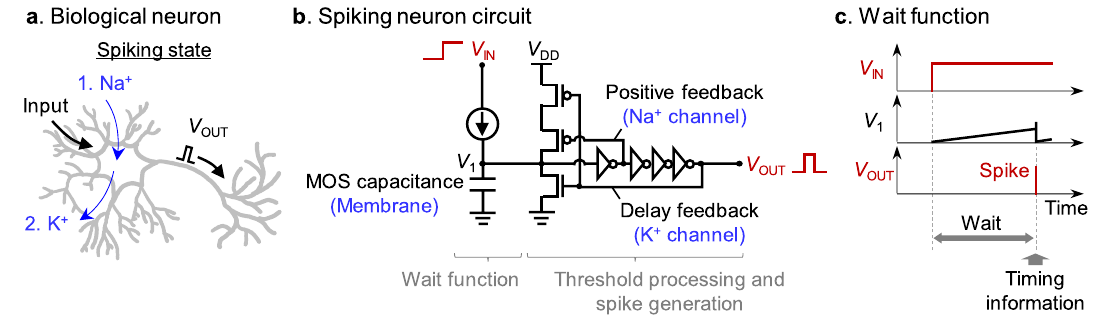
Figure 3. CMOS spiking neuron circuit. ( a ) A schematic illustration of a biological neuron. ( b ) A CMOS spiking neuron circuit with the integrate-fire function, which is used for the waiting time generator. ( c ) A schematic illustration of V IN , V 1 , and V OUT in ( b ) as a function of time. A waiting time corresponds to the period between the onset of